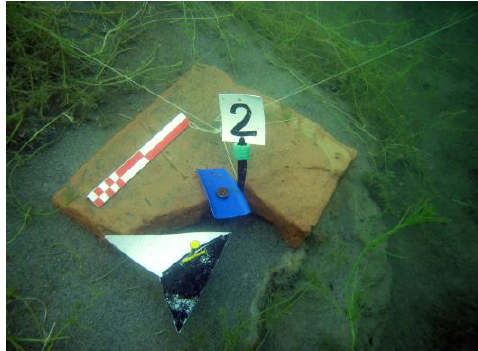
Figure 5. Gambulaga – Portomaggiore (FE), Tramonto Lake. Roman Brick with metrical reference and